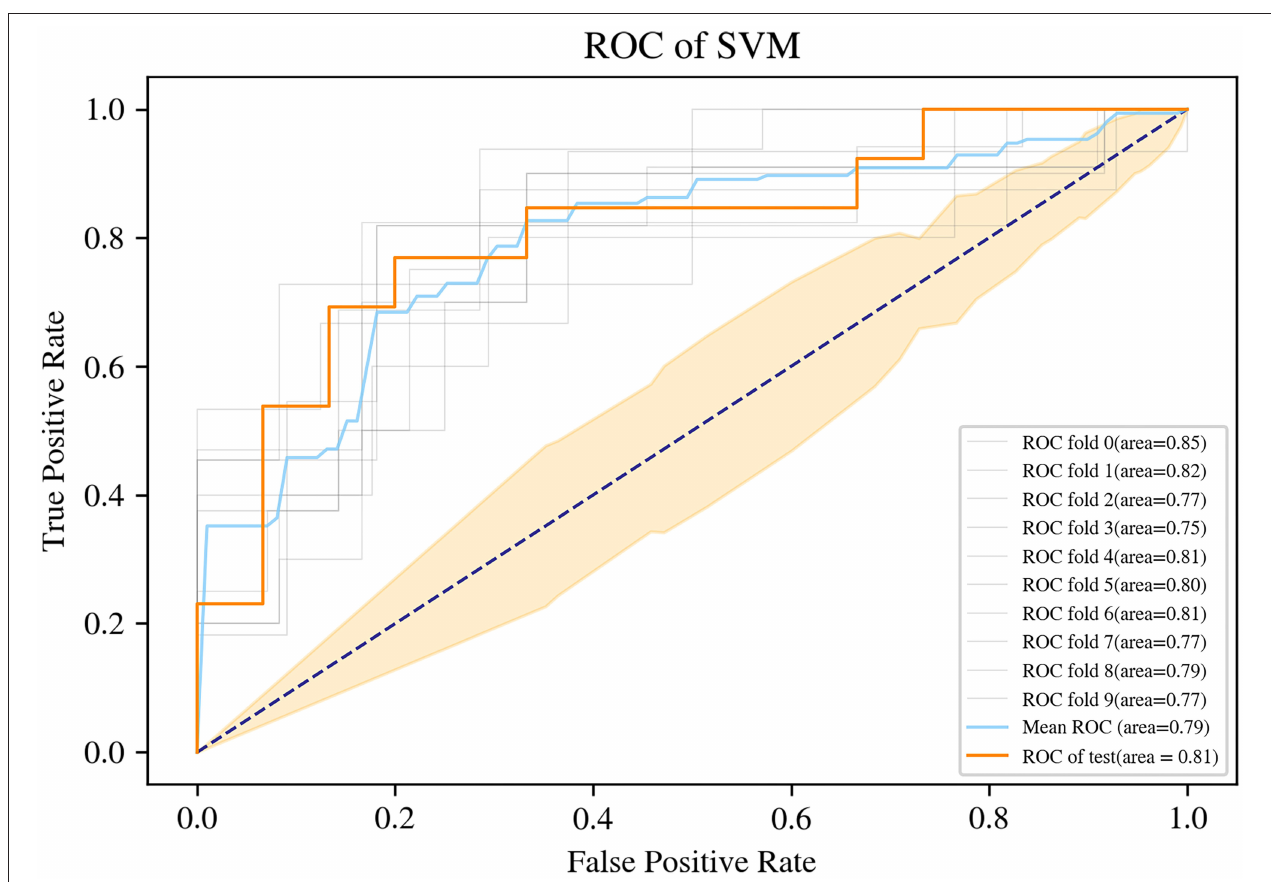
FIGURE 5 | Receiver operating characteristic (ROC) curve of the support vector machine (SVM) machine learning method.